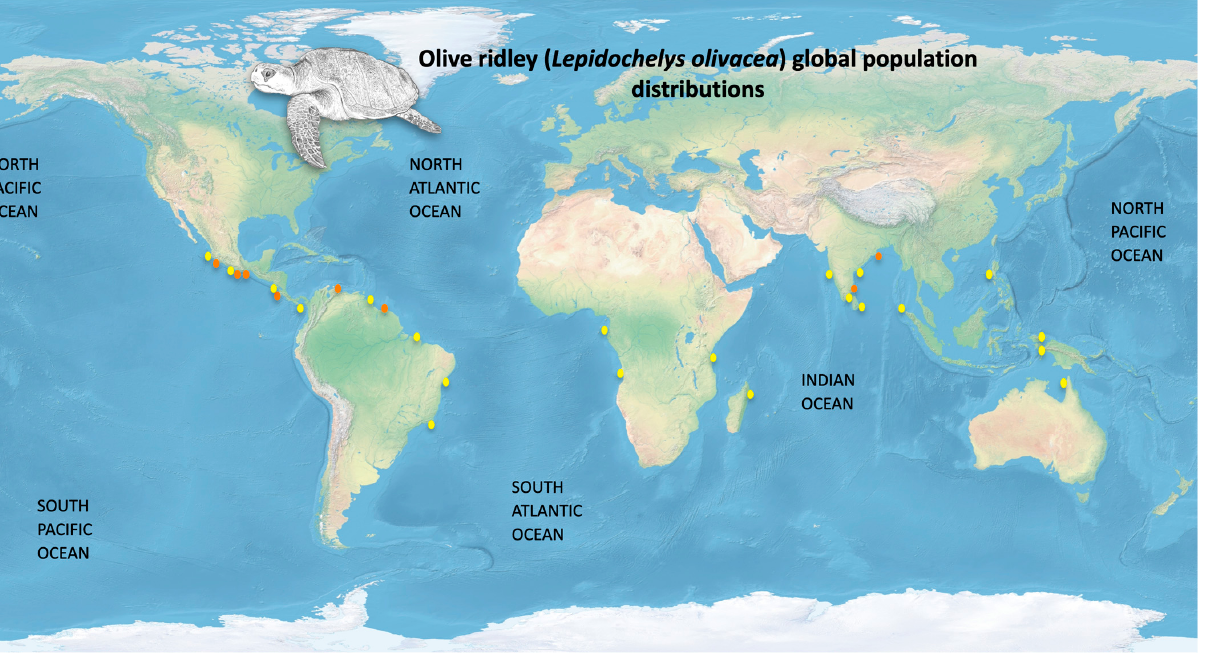
Figure 1. Olive ridley sea turtle ( L. olivacea ) distribution map: Orange circles are major nesting grounds; yellow circles are minor nesting sites (Image taken and modified from [36] with data collected from